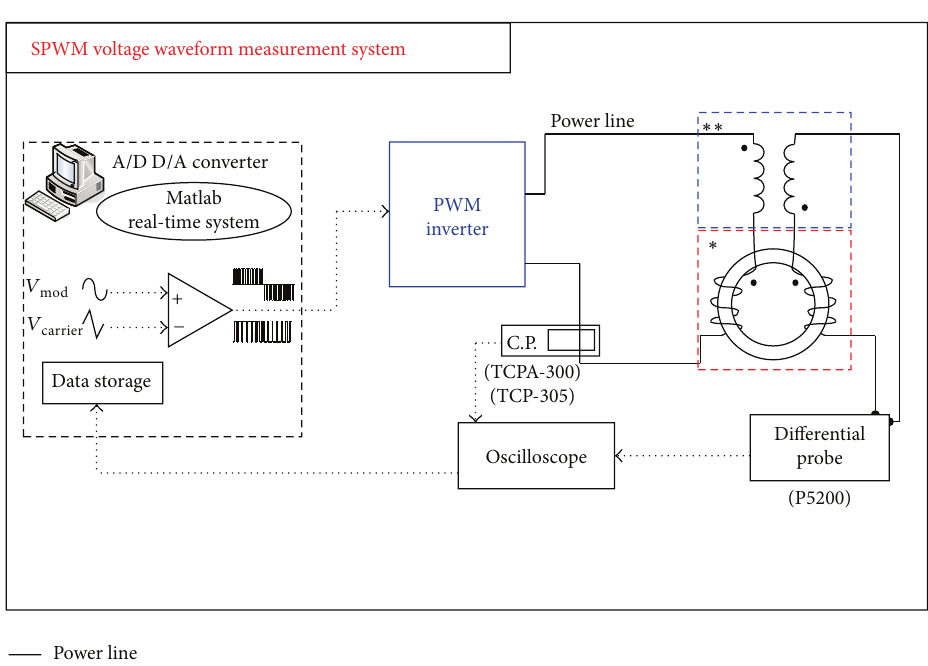
Figure 10: Measurement system under PWM voltage waveform. ∗ Standardized toroidal frame with high repeatability, ∗∗ air-flux compensator